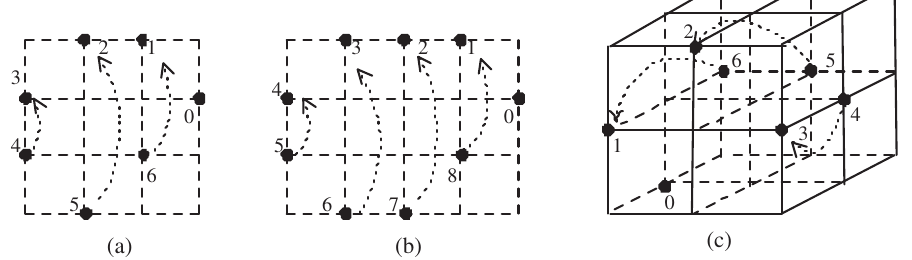
)) for the particular cases given in Example 1, where l is 8